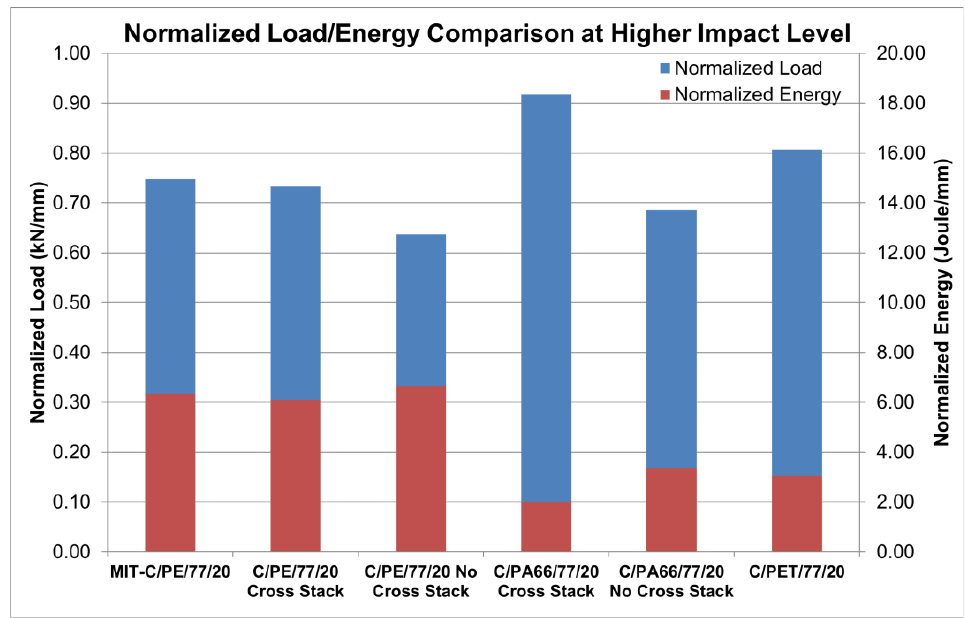
Figure 4. Comparison normalized load and normalized energy for rCF variants at 15 J impact energy .